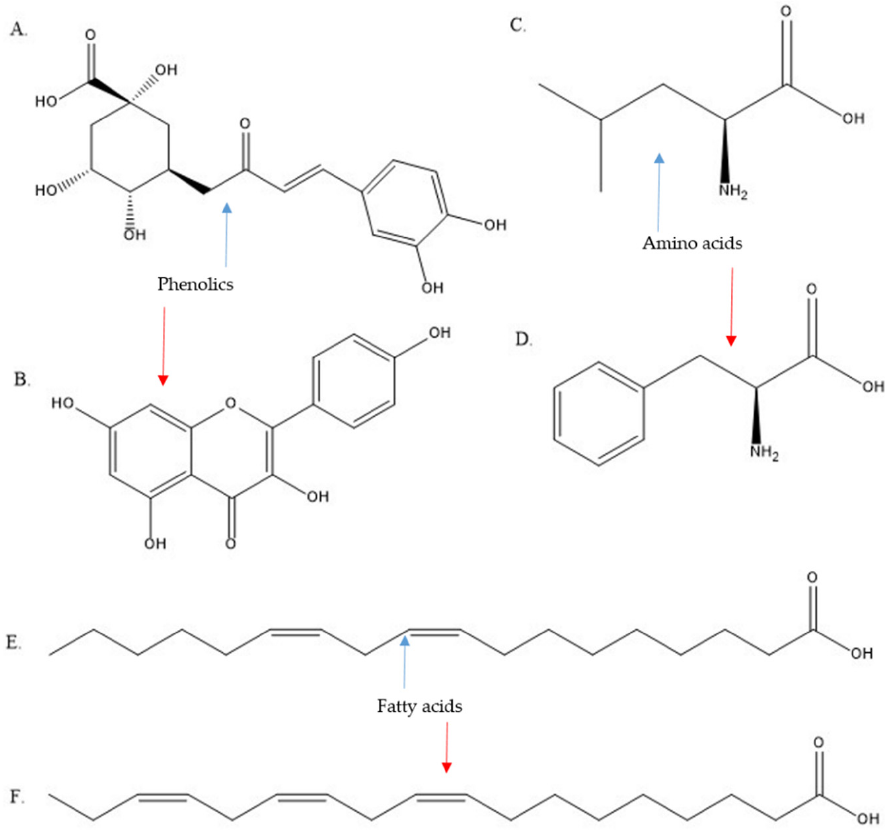
Figure 4. Chemical structure of major bioactive compounds contained in the aerial parts of sea fennel: ( A ). chlorogenic acid (C 16 H 18 O 9 ), ( B ). kaempferol (C 15 H 10 O 6 ), ( C ). leucine (C 6 H 13 NO 2 ), ( D ). phenylalanine (C 9 H 11 NO 2 ), ( E ). linoleic acid (C 18 H 32 O 2 ) and ( F ). linolenic acid or a-linolenic acid (C 18 H 30 O 2